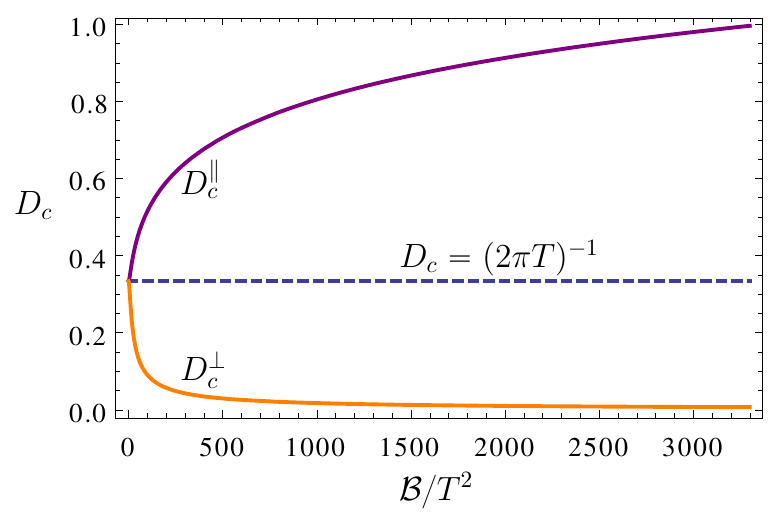
Figure 11 . Electric di(cid:11)usivity D c versus the dimensionless parameter curve represents the electric di(cid:11)usivity along the direction of the magnetic (cid:12)eld, while the orange (bottom) one stands for the electric di(cid:11)usivity along any direction perpendicular to the magnetic (cid:12)eld. The horizontal line is at the value of the conformal result D c = (2 (cid:25)T ) (cid:0) 1 . which is consistent with the results from [8] for a d dimensional CFT, D c = d